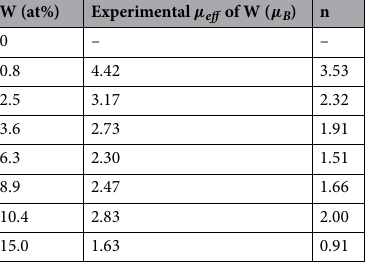
Table 1. Experimental µ eff values provided insight into the number of unpaired spins, n in the